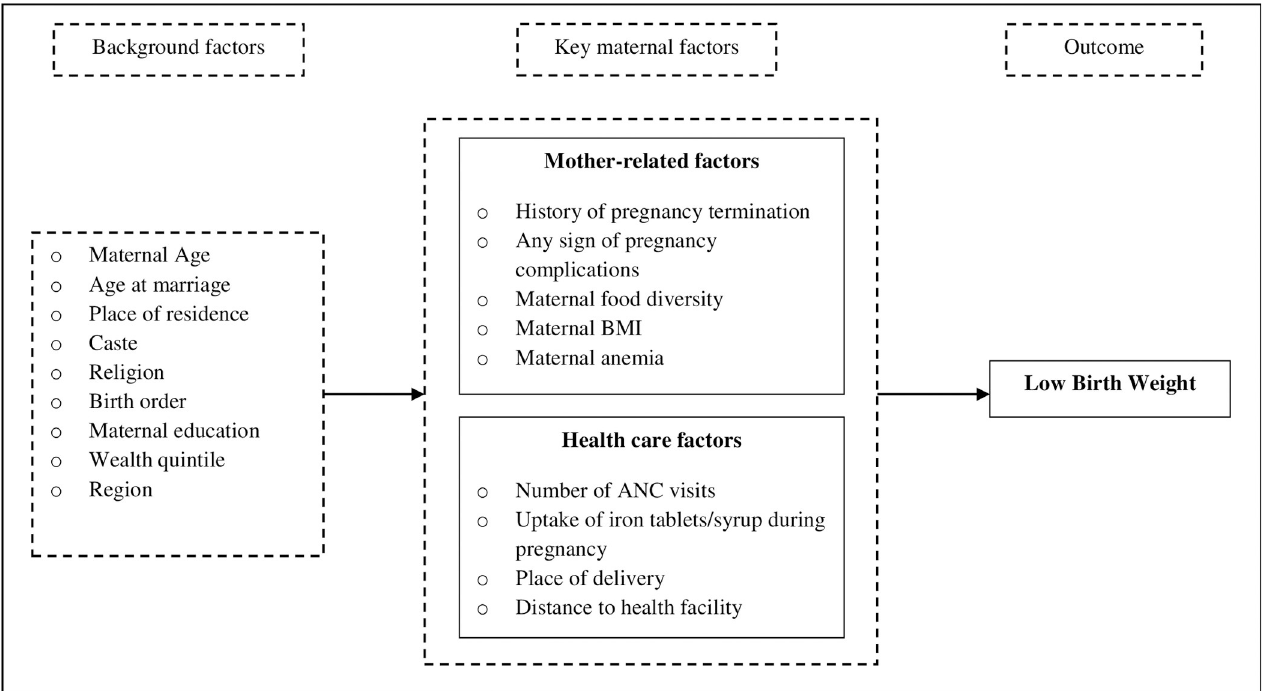
Fig 2. Conceptual framework showing maternal determinants of low birth weight.